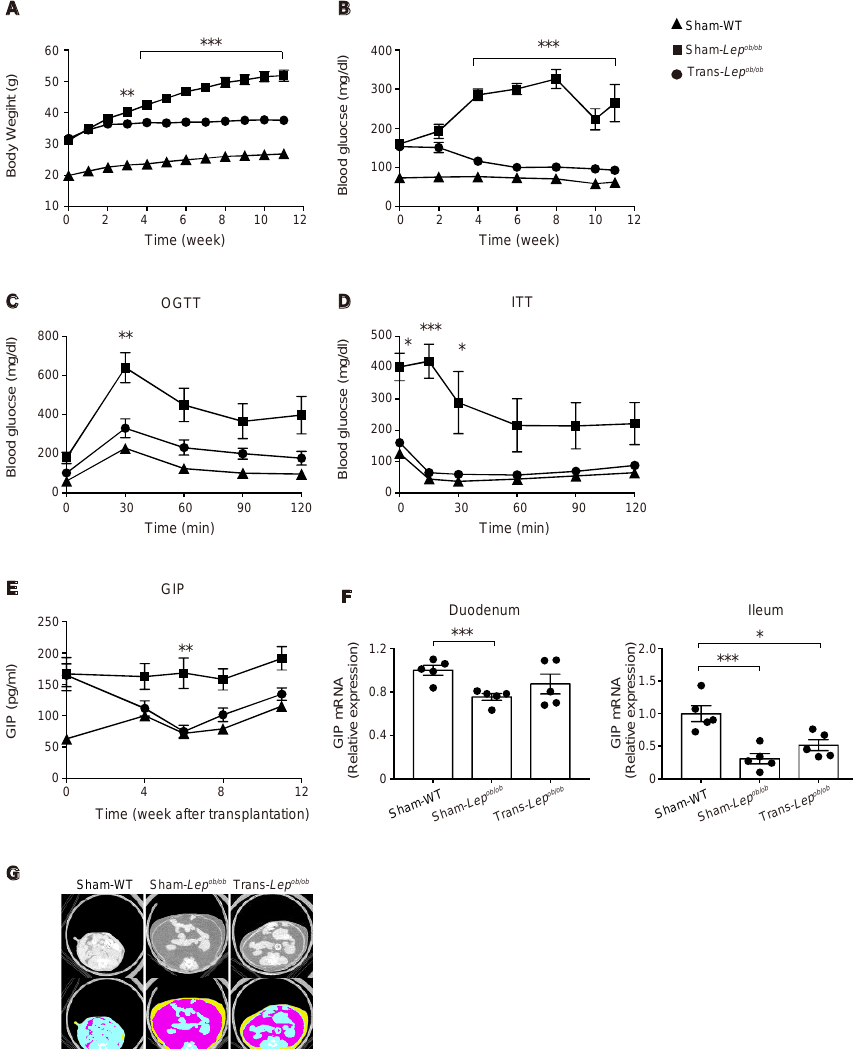
Figure 6. Effect of fat transplantation to Lep ob/ob mice on body weight, glucose metabolism, plasma GIP levels, GIP expression in the gut, and adiposity. ( A – G ) Body weight ( A ), blood glucose levels ( B ), oral glucose tolerance test ( C ), insulin tolerance test ( D ), plasma GIP levels ( E ), mRNA expression of GIP in the gut ( F ), and CT images ( G ) of Trans- Lep ob/ob , Sham- Lep ob/ob , and Sham-WT. ( A – G ): Results of Trans- Lep ob/ob (circles), Sham- Lep ob/ob (squares), and Sham-WT (triangles) are shown. Data are expressed as mean ± SEM. ( A – D , E ) n = 9–10; ( F ) n = 5. * p < 0.05, ** p < 0.01, *** p < 0.001. ( G ): Representative CT images at the level of lower end of right kidney. Plain images (upper) and colored images (lower) of visceral (pink) and subcutaneous fat